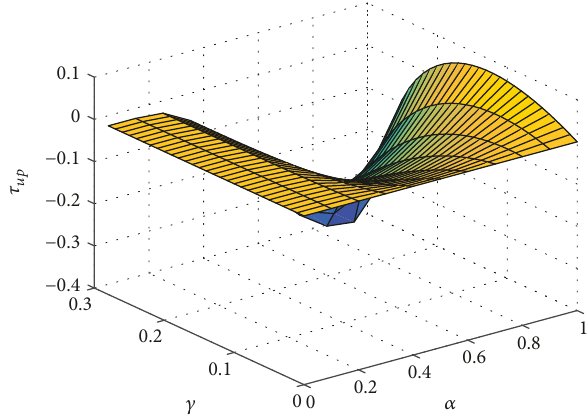
Figure 1: The three-dimensional diagram of τ parameters α and γ in case 1.